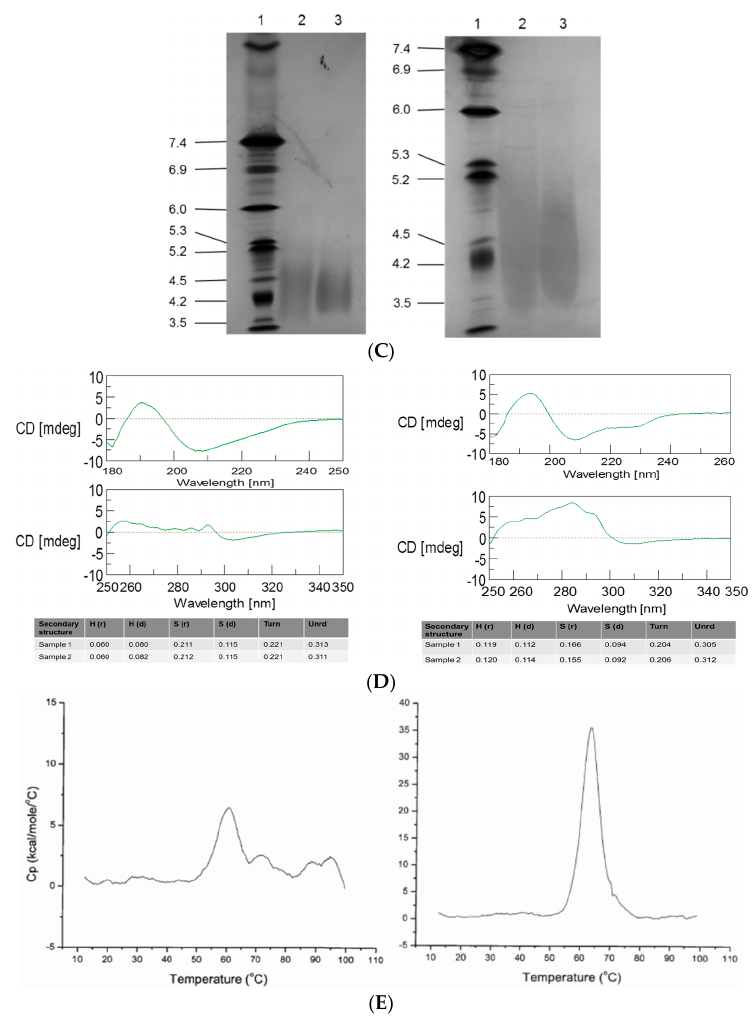
Figure 1. SDS-PAGE profiles, intact molecular determination, charge heterogeneity, CD, and DSC analysis of HIV TV1.C and 1086.C gp120. ( A ) Reduced SDS-PAGE profile of TV1.C and 1086.C gp120 before (lanes 1 and 2) and after (lanes 3 and 4) de- N -glycosylation by PNGase F. ( B ) MALDI-TOF analysis measures the intact molecular weight of TV1.C (left panel) and 1086.C (right panel) gp120s at 105.04 KDa and 94.94 KDa, respectively. ( C ) IEF gel analysis of 1086.C gp120 and TV1.C showing the pI of gp120s being 3.5–5.2. Left panel, pH 3–10; Right panel, pH 3–7. Lane 1, marker; Lane 2, TV1.C; Lane 3, 1086.C. ( D ) CD analysis of TV1.C (left panel) and 1086.C (right panel) gp120s. Upper spectra, far UV; middle spectra, near UV; lower table, secondary structure elements predicted by CDPro Analysis, using CONTIN method and SP43 reference database. Testing was in duplicate (Sample 1 and Sample 2). ( E ) DSC scans determine the Tm of TV1.C (left panel) and 1086.C (right panel) gp120s at 61.2 °C and 63.7 °C, respectively.